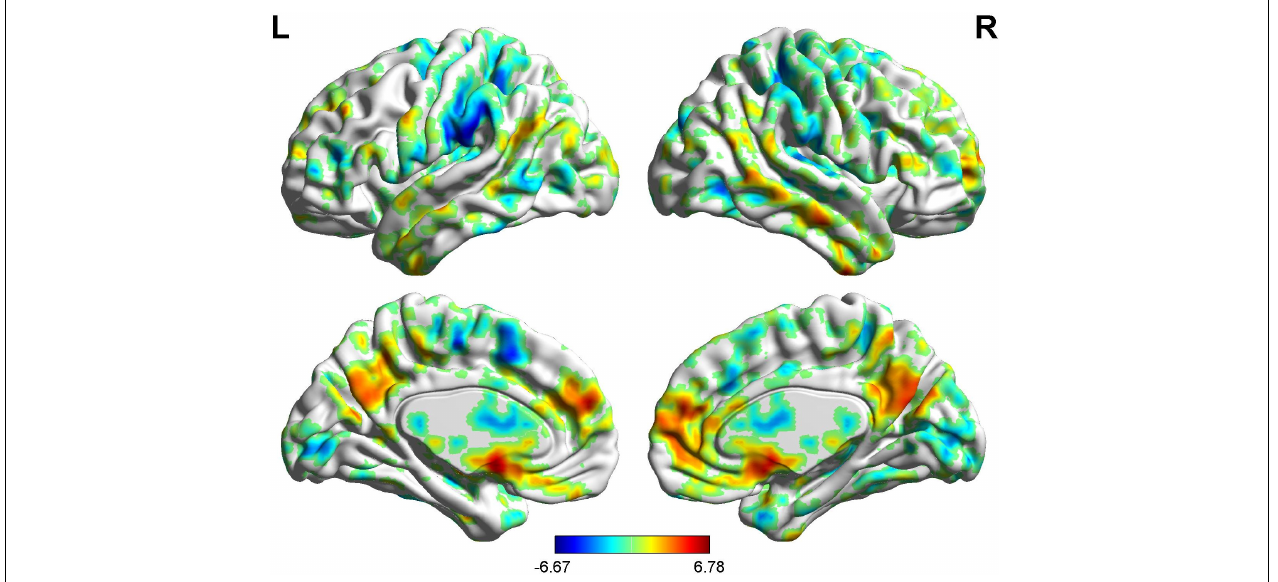
FIGURE 7 | Brain areas showing functional connectivity with the rACC in comparison of male participants and female participants in placebo response. Color scale represents the Z -score. Red = male > female; blue = female > male.